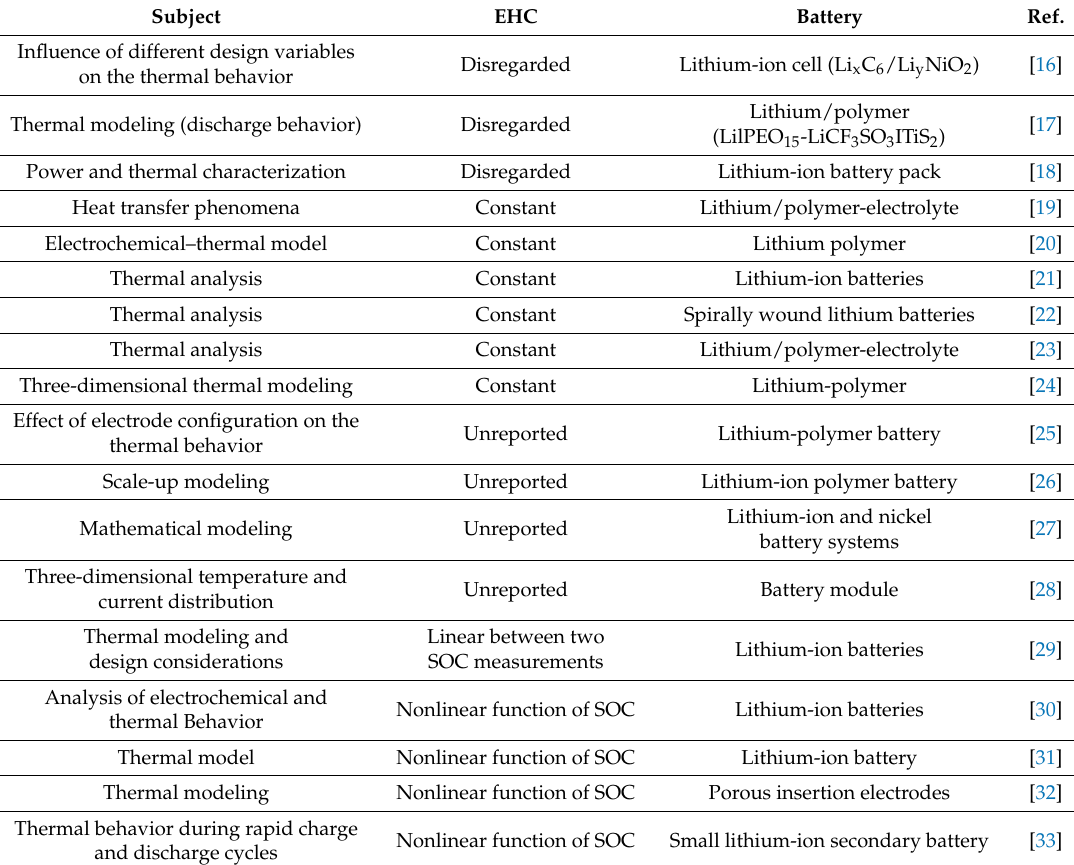
Table 4. Investigations of which entropic heat was exerted to the thermal